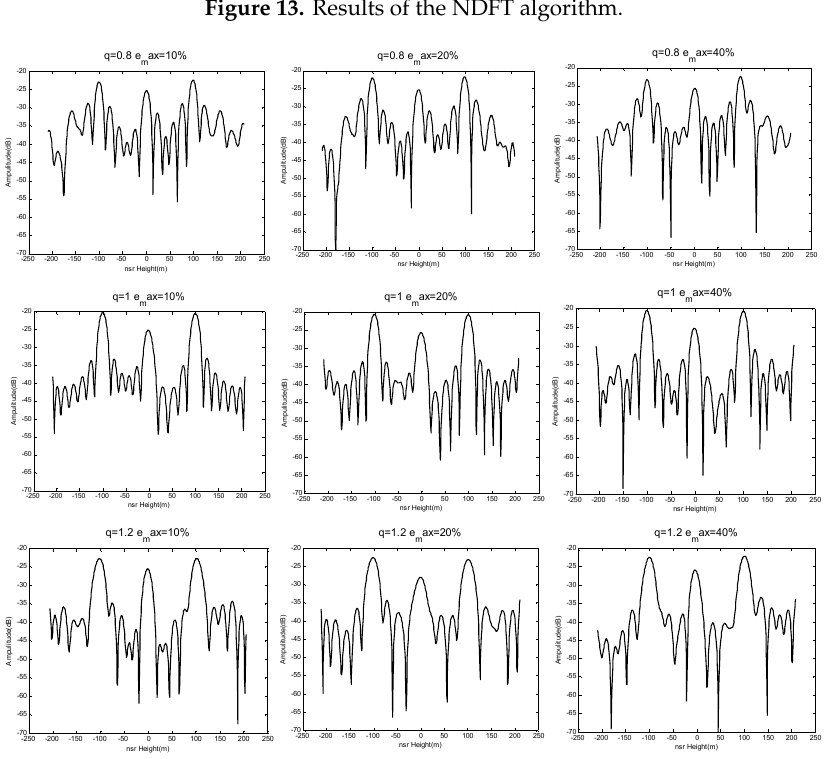
Figure 13. Results of the NDFT algorithm.